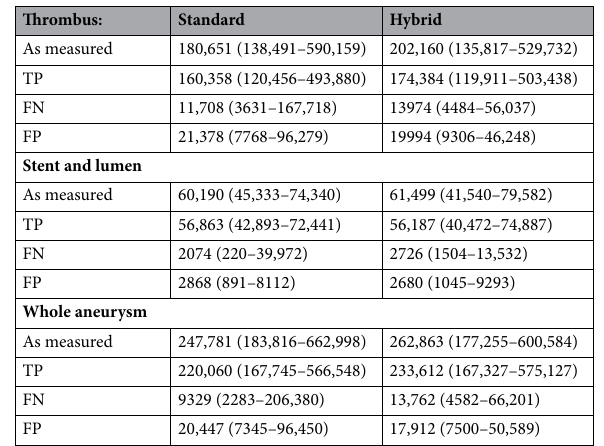
Table 1. Standard and Hybrid pipeline accuracy in aneurysm segmentation. Units displayed are volume 3 (mm ), given as median (range).